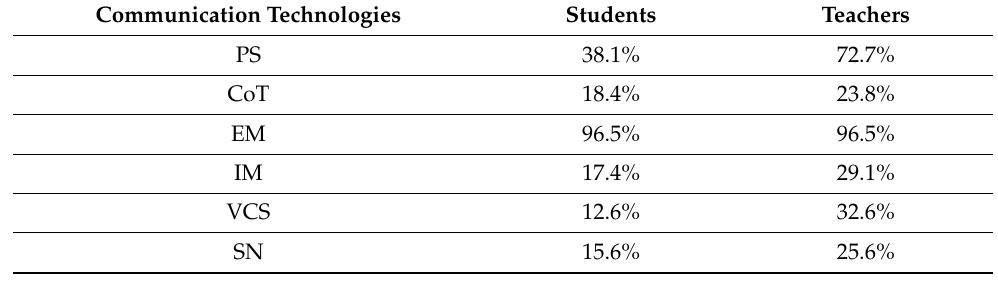
Table 6. Communication technologies used by students and teachers.